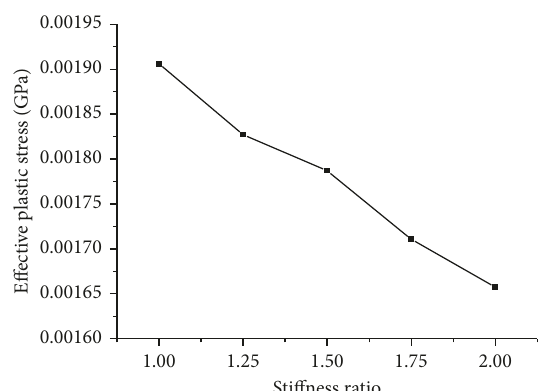
Figure 10: Comparison of effective plastic strain.